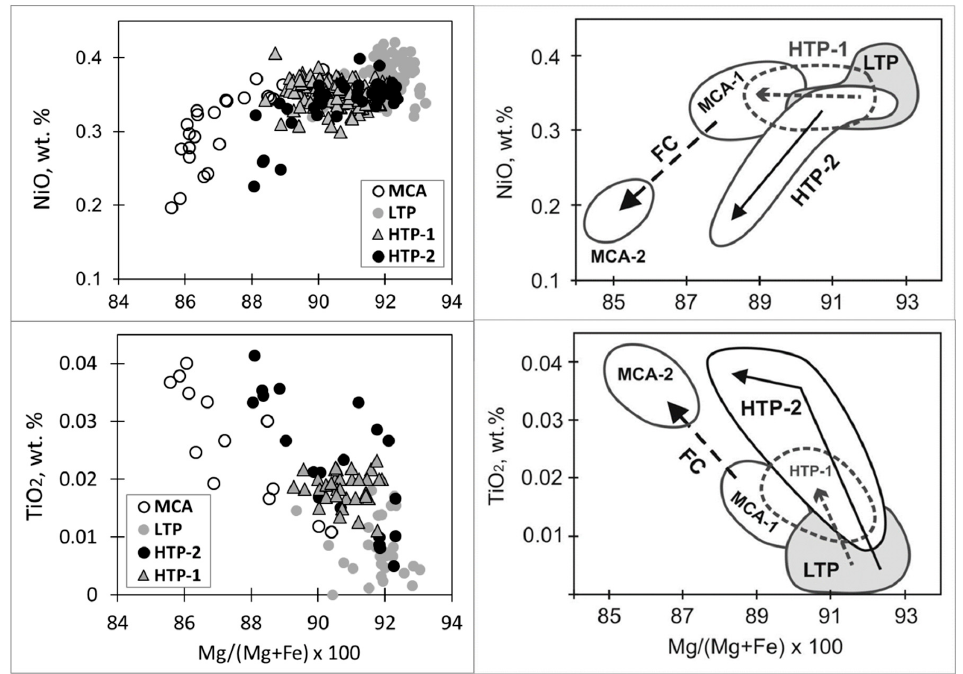
Figure 8. Origin of olivines in kimberlites from the northern Siberian craton: olivines from the Dianga kimberlite (left) and a model of their formation (right). Olivine types: MCA-1 and MCA-2 are early and late low-Cr megacrysts, respectively; LTP = low-temperature lherzolite < 1100 °C, HTP-1 = high-temperature peridotite > 1300 °C, HTP-2 = high-temperature peridotite 1100–1300 ° С ; FC = fractional crystallization of low-Cr megacryst olivines.